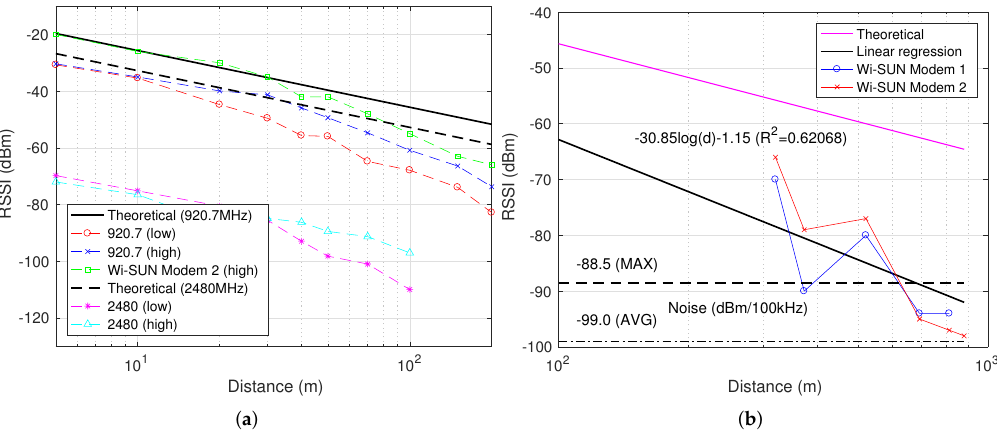
Figure 12. LOS experiments of Wi-SUN and ZigBee modems. ( a ) Experiments of a range from 5 m to 200 m (Wi-SUN and ZigBee), where the attenuation rate (AR) values start from − 20.0. ( b ) Experiments of a range from 100 m to 1000 m (Wi-SUN), where the AR value is − 31.0.